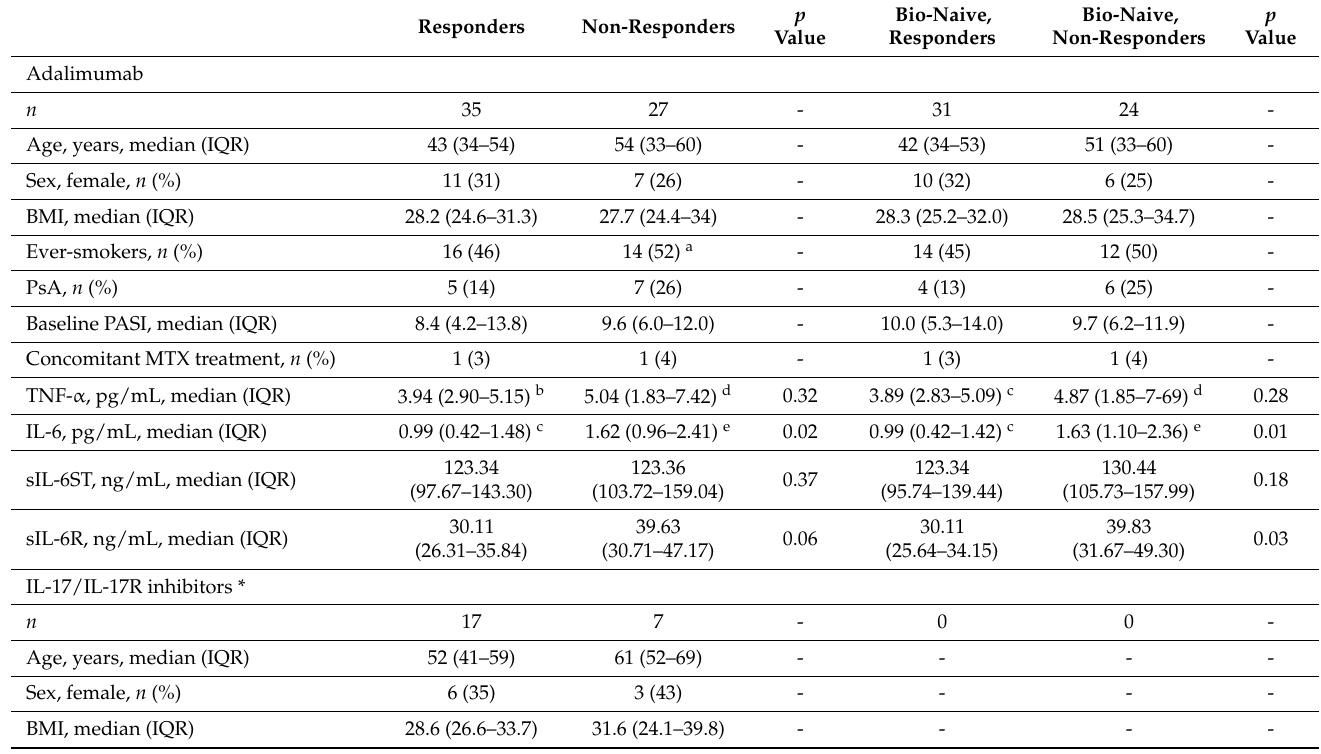
Table 3. Baseline characteristics and cytokine